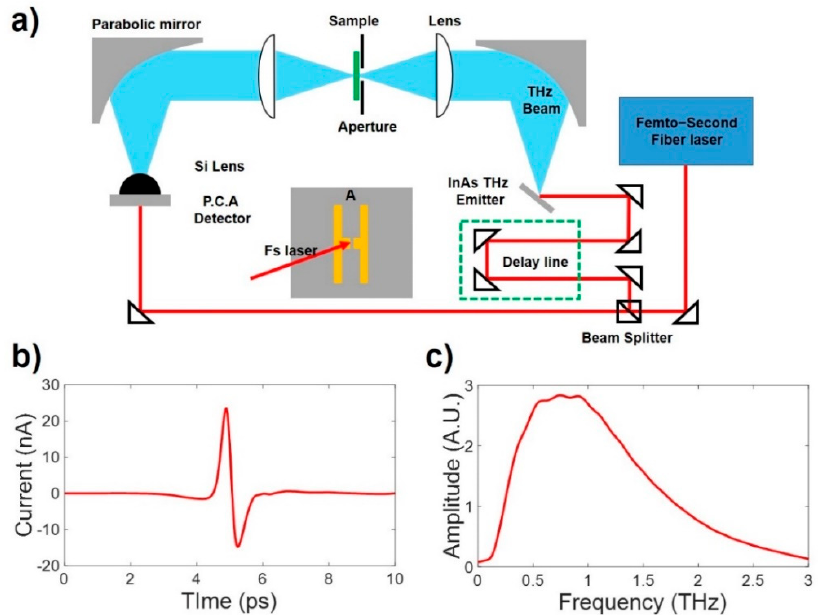
Figure 3. ( a ) Illustration of the THz-TDS measurement scheme. The THz pulse is generated by the InAs wafer. The THz pulse is detected by using PCA. Reference THz pulse propagation through air is measured. ( b ) Time domain signal. ( c ) Fast Fourier Transform (FFT) of ( b ).